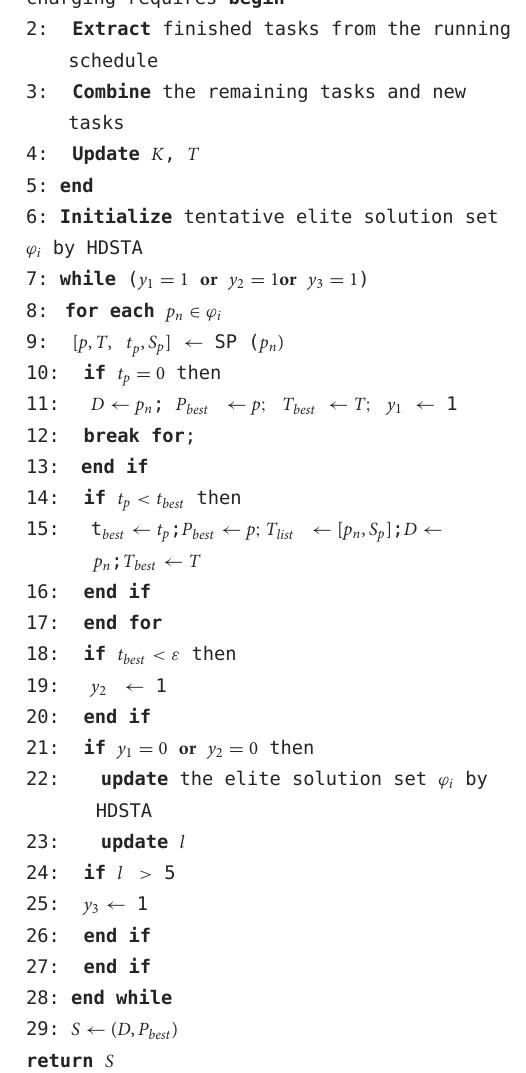
Algorithm 1. Main scheme of hierarchical planning.